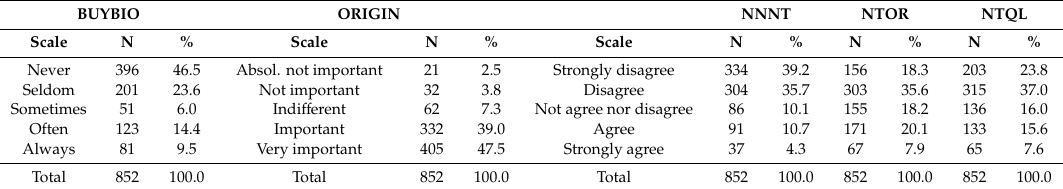
Table 3. Distribution of selected